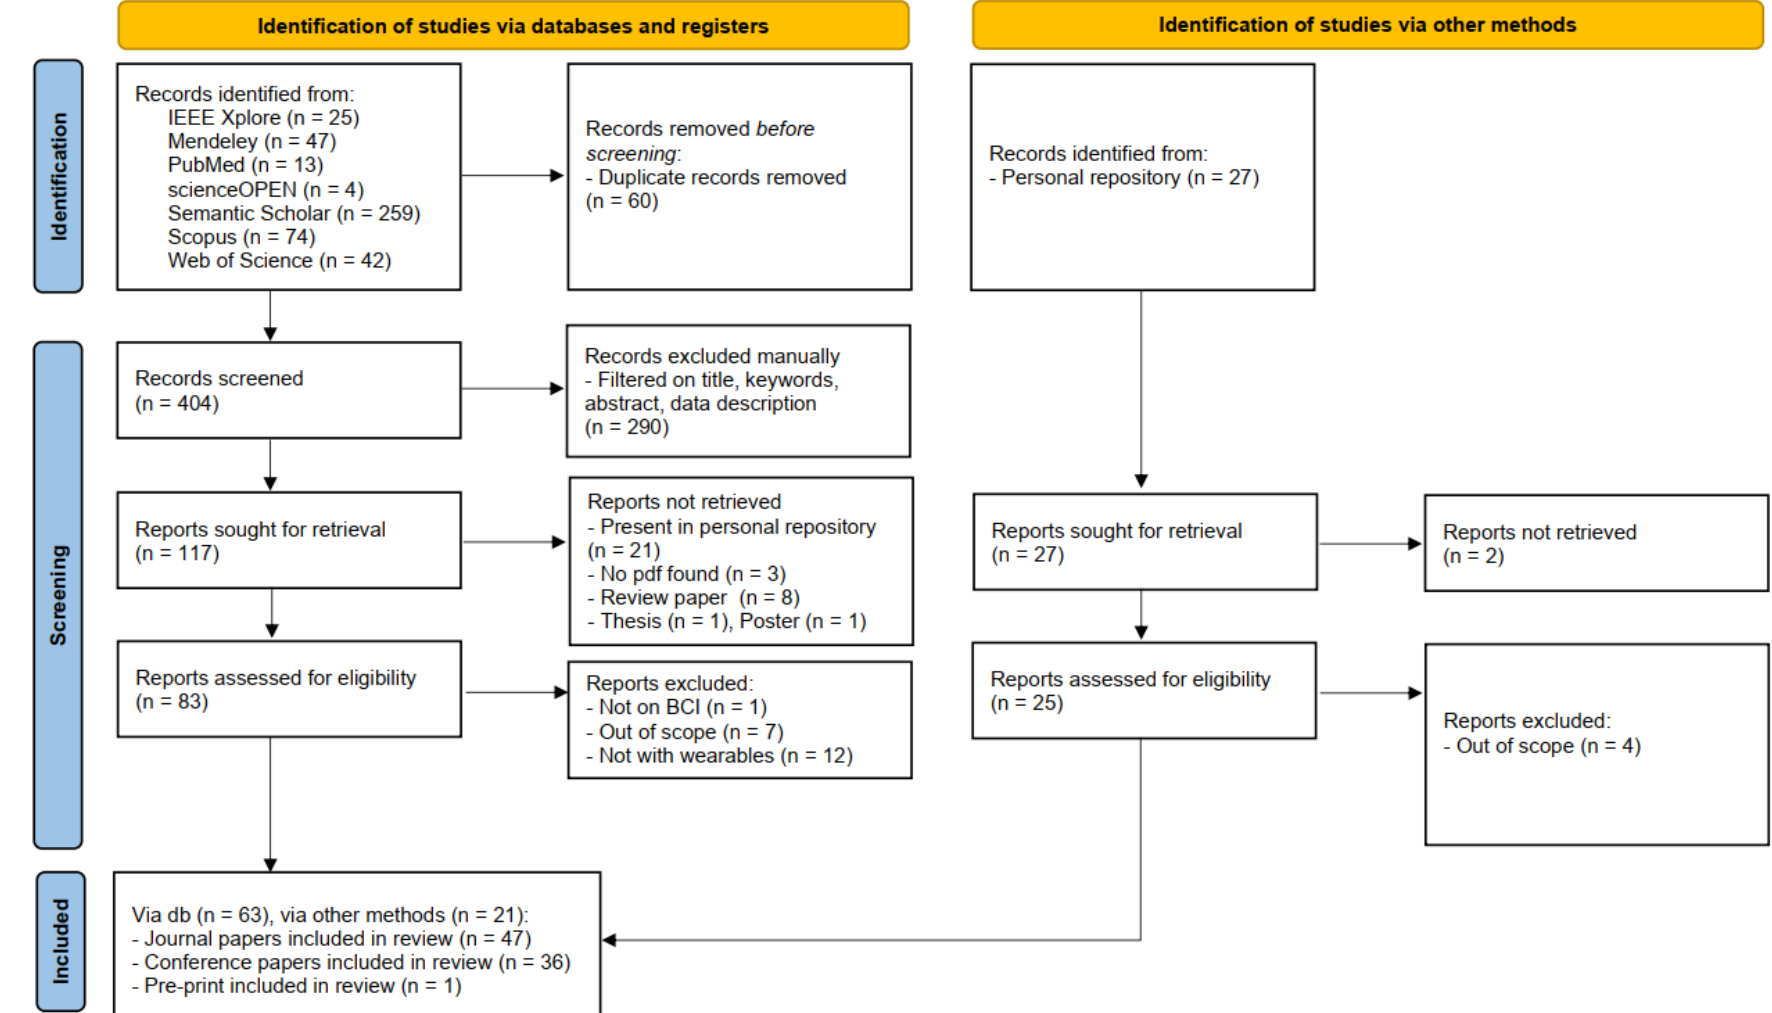
Figure 1. Flow diagram obtained by following the PRISMA